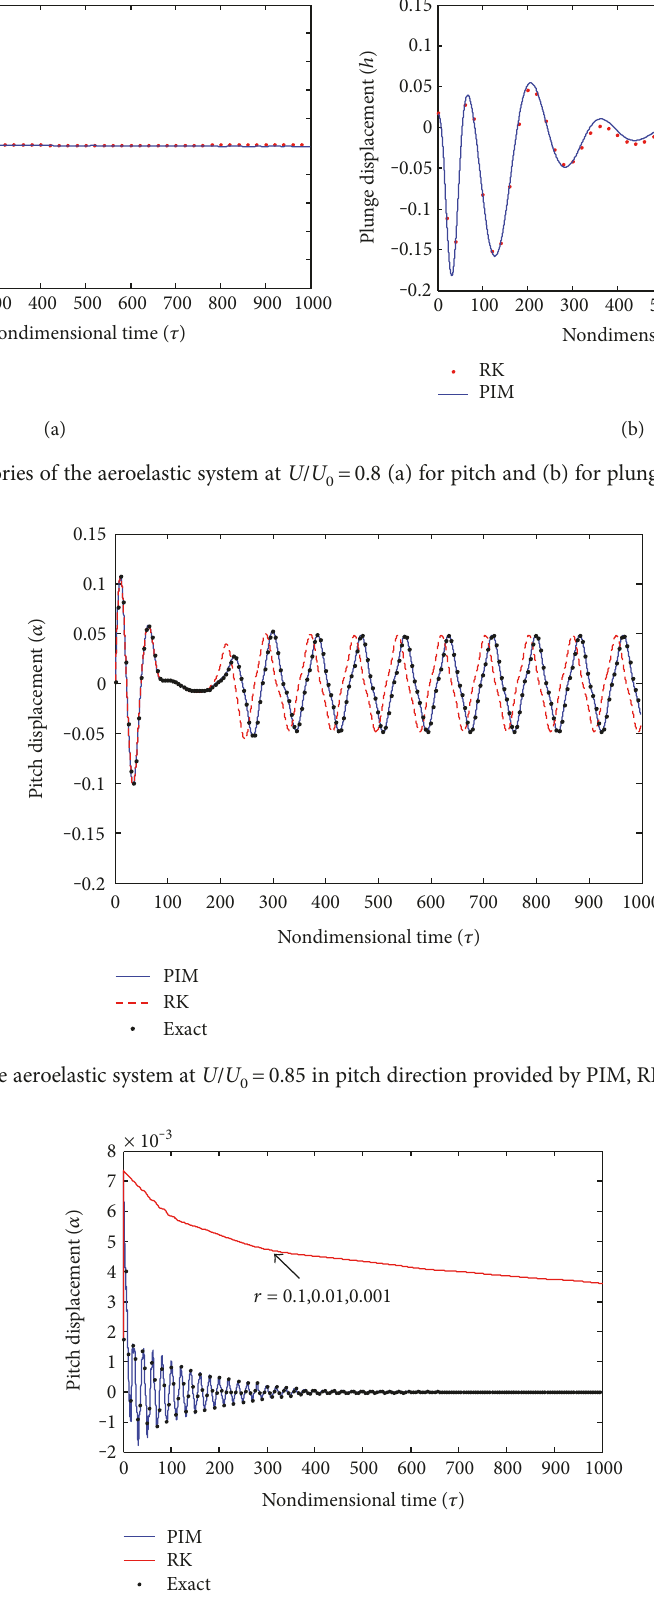
Figure 11: Time histories of the aeroelastic system at U / U the time step as 0.1, 0.01, or 0.001, respectively.